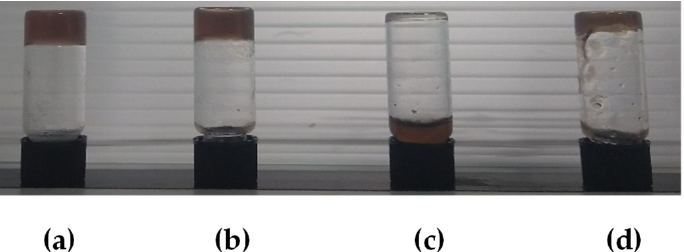
Figure 3. Inversion tube tests for the L1 gel formation in the presence of a 1:2 molar ratio of different anion species as tetrabutylammonium salts: ( a ) Cl − ; ( b ) H 2 PO 4 − ; ( c ) F − ; ( d ) BzO − at 2% w / v of L1 in DMSO/H 2 O (H 2 O 15% v / v ).